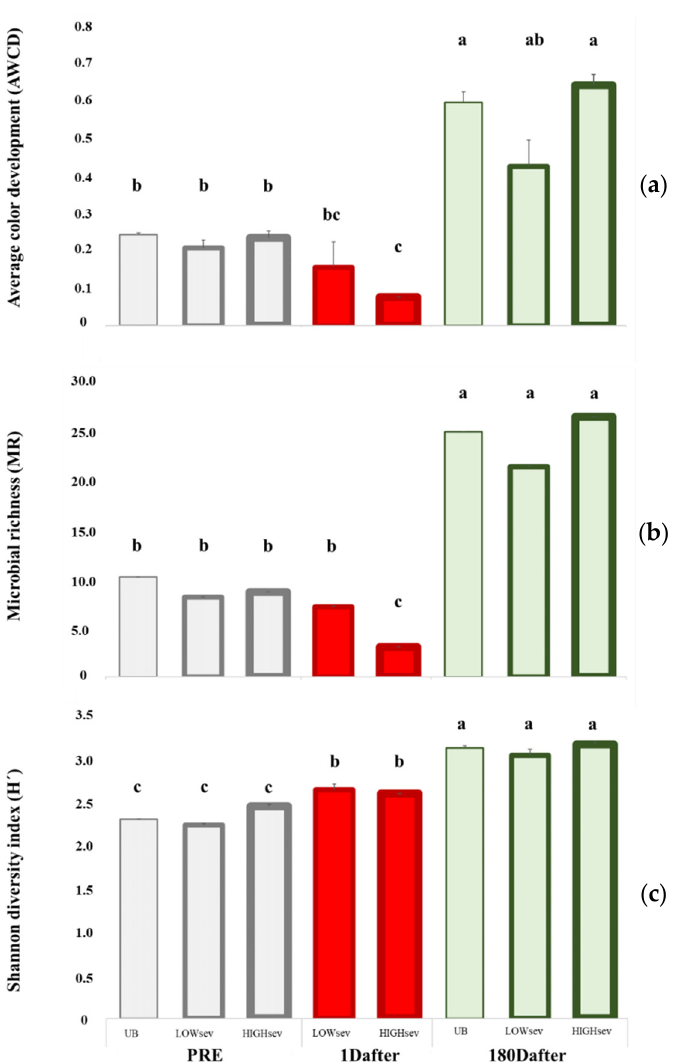
Figure 2. Community-level physiological profiles (CLPPs) were characterized after 96 h of incubation in the midexponential growth phase in the soil samples of the burned lysimeters at MedForE- COtron (14 July 2016) collected prefire (7 days before, PRE), 1 day after (1Dafter) and 6 months after (180Dafter): ( a ) average well-color development (AWCD); ( b ) microbial richness (MR); ( c ) the Shannon diversity index (H’). Burn severity levels: unburned (UB), low burn severity (LOWsev), and high burn severity (HIGHsev). Vertical bars represent the standard error of the mean, and lowercase letters indicate significant differences between the means of the different groups (Fisher’s least significant difference test).